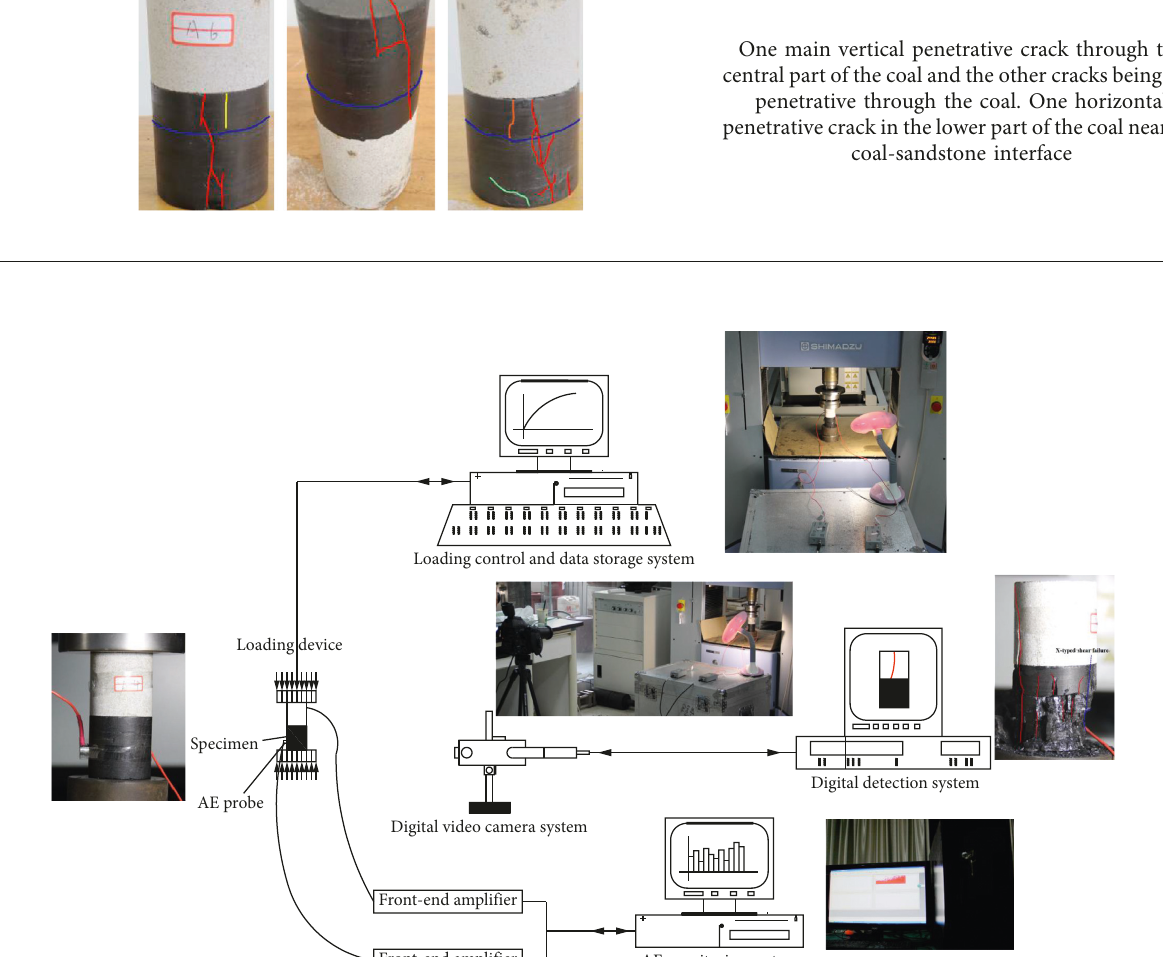
Figure 1: Test equipment and monitoring